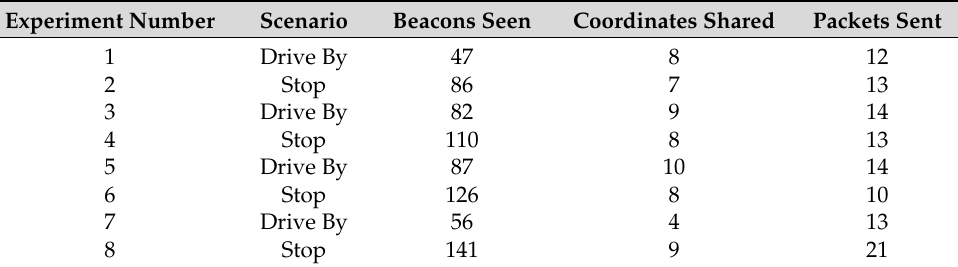
Table 8. Network performance during